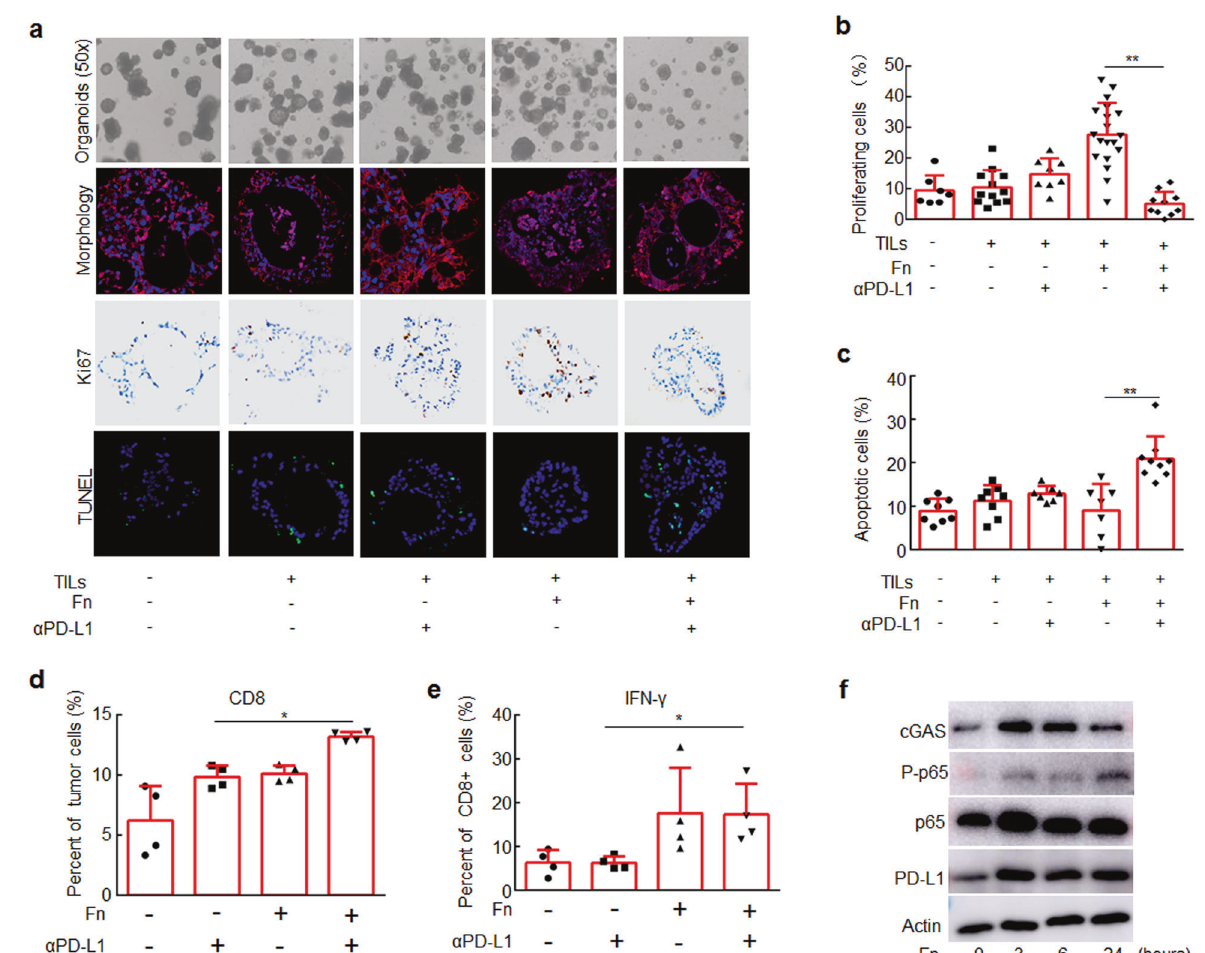
Fig. 6 CRC Organoids treated with F. nucleatum were more responsive to PD-L1 blockade than those not treated with F. nucleatum . CRC organoids were mixed with T lymphocytes (10 5 /well) and F. nucleatum (10 8 CFU) and treated with an anti-PD-L1 mAb or an isotype control mAb for one week. a CRC organoids in different groups. Organoid morphology was examined by staining for E-cadherin (red) and with DAPI (blue). Ki-67 expression was detected by IHC (brown staining). Cell apoptosis was detected by TUNEL staining (green). b The proportions of proliferating cells were detected by Ki-67 staining. c The proportions of apoptotic cells were detected by TUNEL staining. One-way ANOVA and Bonferroni ’ s multiple comparison test. d , e Flow cytometry was used to detect the proportion of CD8 + cells in CRC organoids and the proportion of IFN- γ + cells in CD8 + cells in different groups. One-way ANOVA and Bonferroni ’ s multiple comparison test. f CRC organoids were treated with F. nucleatum for different time course. The indicated proteins were detected by Western blotting. One-way ANOVA and Bonferroni ’ s multiple comparison test. * P < 0.05; ** P < 0.01. Fn, F. nucleatum streptomycin (2 mg/mL) and penicillin (2000 U/mL) for 1 week Immunohistochemistry (IHC) before CT26.WT cells (5 × 10 6 ) were subcutaneously injected into IHC was applied to detect protein expression according to a standard protocol. 36 Immunohistochemical staining was per- the right fl ank. The mice were randomized into different groups. formed with an anti-PD-L1 antibody (1:100, Roche, clone no. SP263) and anti-Ki-67 antibody (1:100, Gene Tech, clone no. SP6). Cells showing membranous staining for PD-L1 and nuclear staining for Ki-67 were considered as positive cells. For the detection of mismatch repair (MMR) proteins, The following primary antibodies were used: MLH1 (1:100, Gene Tech, clone no. GM002), MSH2 (1:100, Gene Tech, clone no. RED2), MSH6 (1:100, Gene Tech, clone no. EP49), and PMS2 (1:100, Gene Tech, clone no. EP51). A negative staining of at least one mismatch repair protein is considered to be dMMR. All staining was blindly scored by two pathologists according to the intensity of staining. Mice For xenograft experiments, 4- to 6-week-old male BALB/c mice were obtained from Shanghai Slark Experimental Animal Co., Ltd. The rodents were supplied with drinking water containing by intraperitoneal injection 1 day before treatment with